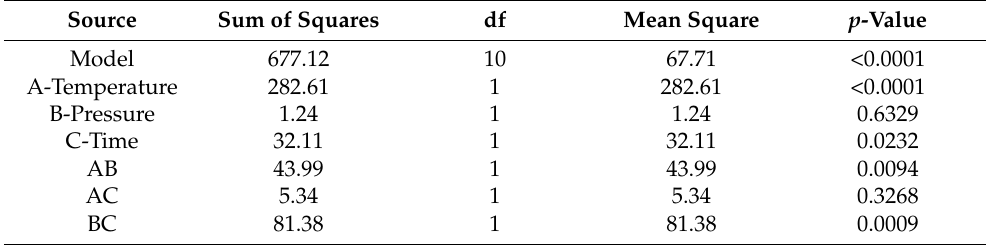
Table 1. The analysis of variance (ANOVA) of the effect of reaction conditions on the extraction yield. Source Sum of Squares df Mean